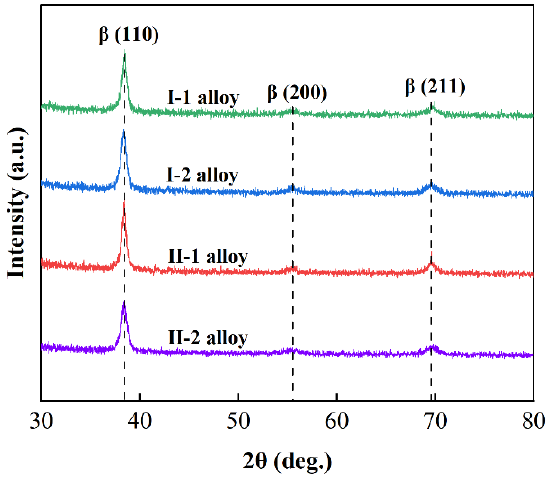
Figure 8. XRD patterns of the Ti – Mo – Nb – Ta – Zr – Sn alloys.